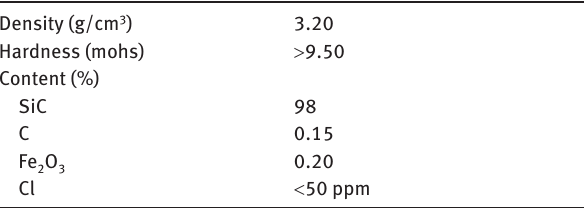
Table 2: Mechanical properties and chemical composition of SiC Density (g/cm 3 )